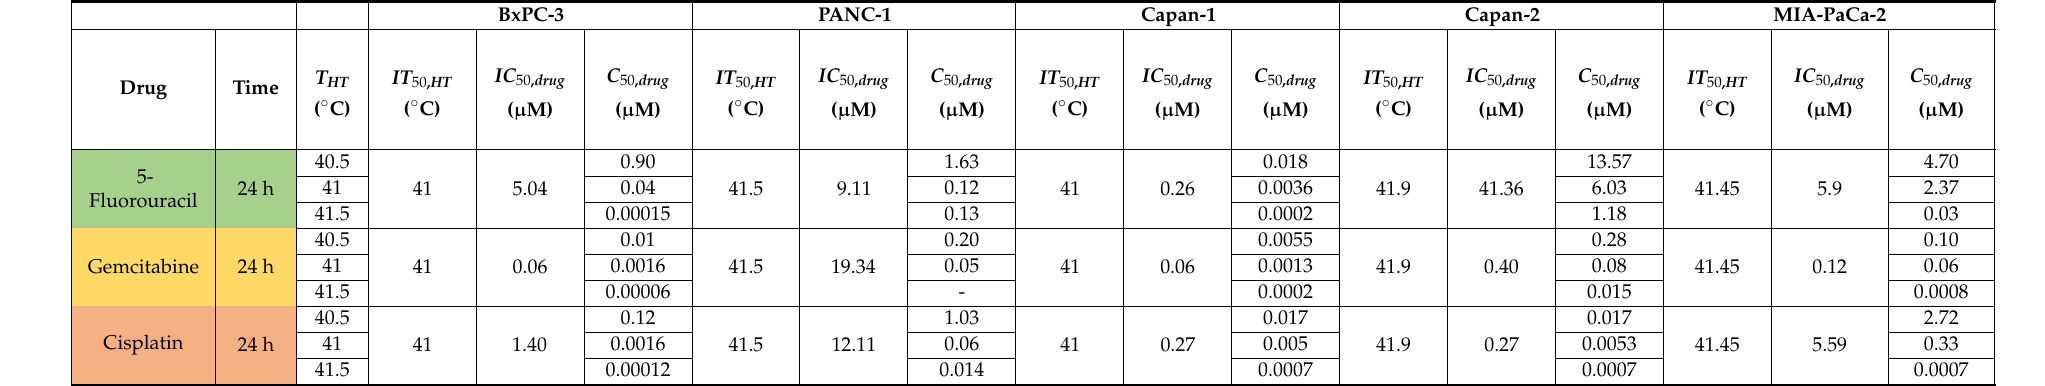
Table 1. IC 50,drug , IT 50,HT and combination doses between hyperthermia for 24 h and 5-fluorouracil, gemcitabine, and